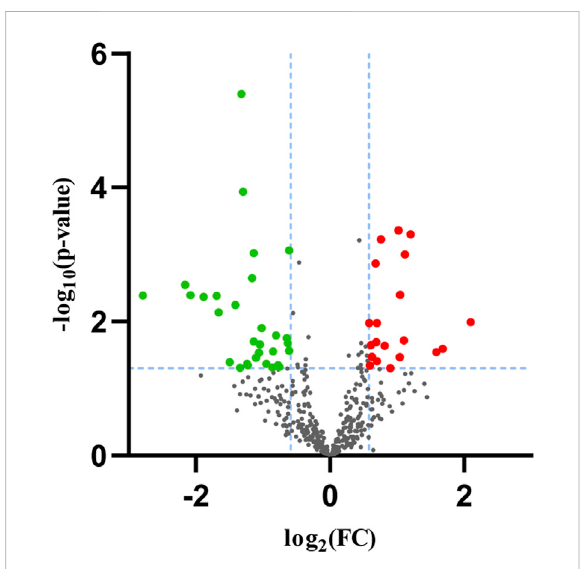
FIGURE 2 The volcano map of differentially expressed